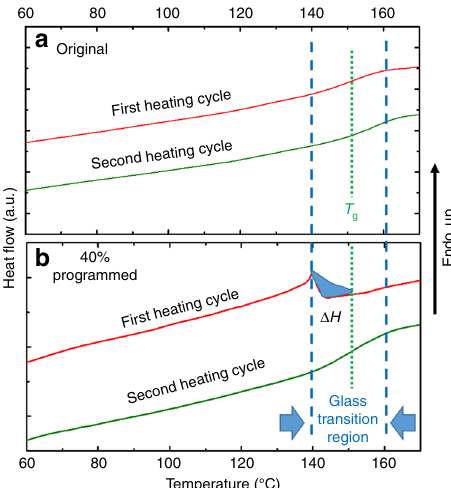
Fig. 2 The enthalpy release during the free shape recovery process by DSC. a The DSC test results for the original SMP after synthesis. To avoid the post-curing effect and to match the thermal history with the programmed sample, the as prepared original SMP sample was heated at 170 °C for over 1 h before the DSC test. The typical glass transition curve, glass transition region, and glass transition temperature can be identi fi ed in the second heating cycle. b The DSC test results for the 40% compressive strain programmed sample. An inverse peak emerges during the fi rst heating cycle in the pre- T g region. The enthalpy release is con fi rmed by this fi rst order transition. This is due to the retreat of stretched bonds formed during programming, which leads to release of the stored enthalpy, and the enthalpy release is Δ H = − 2.85 J/g. The negative sign means the release of enthalpy. After release of the stored enthalpy, the second heating cycle also presents the classical second order glass transition curve. Based on the density of the sample, the speci fi c enthalpy storage is 3.25 MJ/m 3 . Determination of the end points and baseline for calculating the enthalpy can be found in Supplementary Fig.